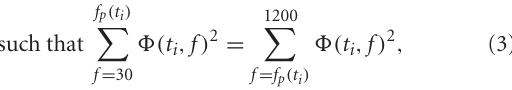
Second, we estimated the peak of intensity in each window of the spectrogram and extracted its corresponding